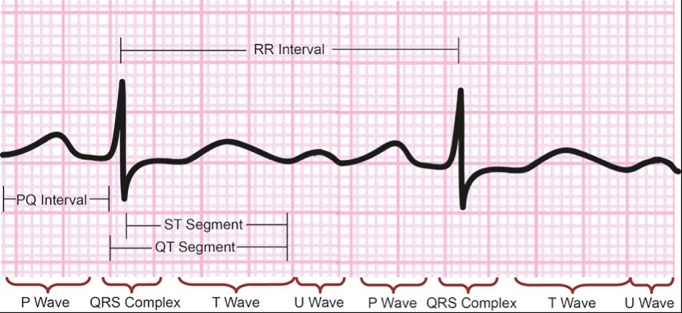
Normal ECG Signal